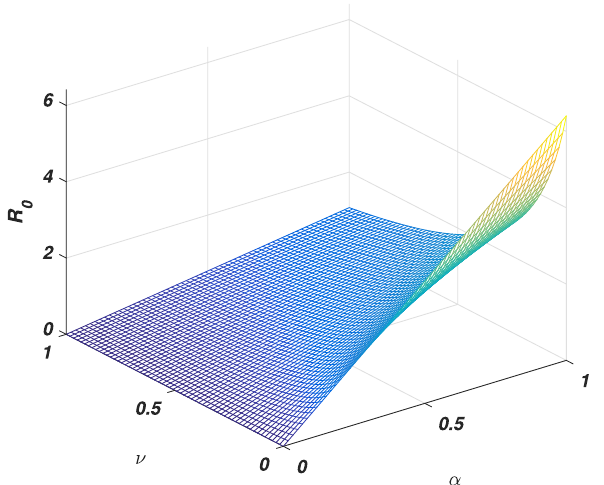
Figure 2. The graph shows the variation of the basic reproductive number against the parameters α and v .